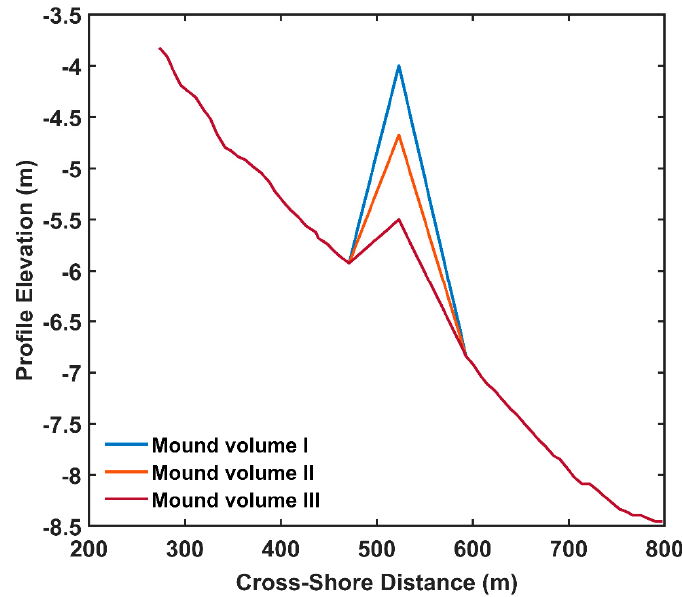
Figure 9. Studied schematized triangular mounds having different initial volumes.